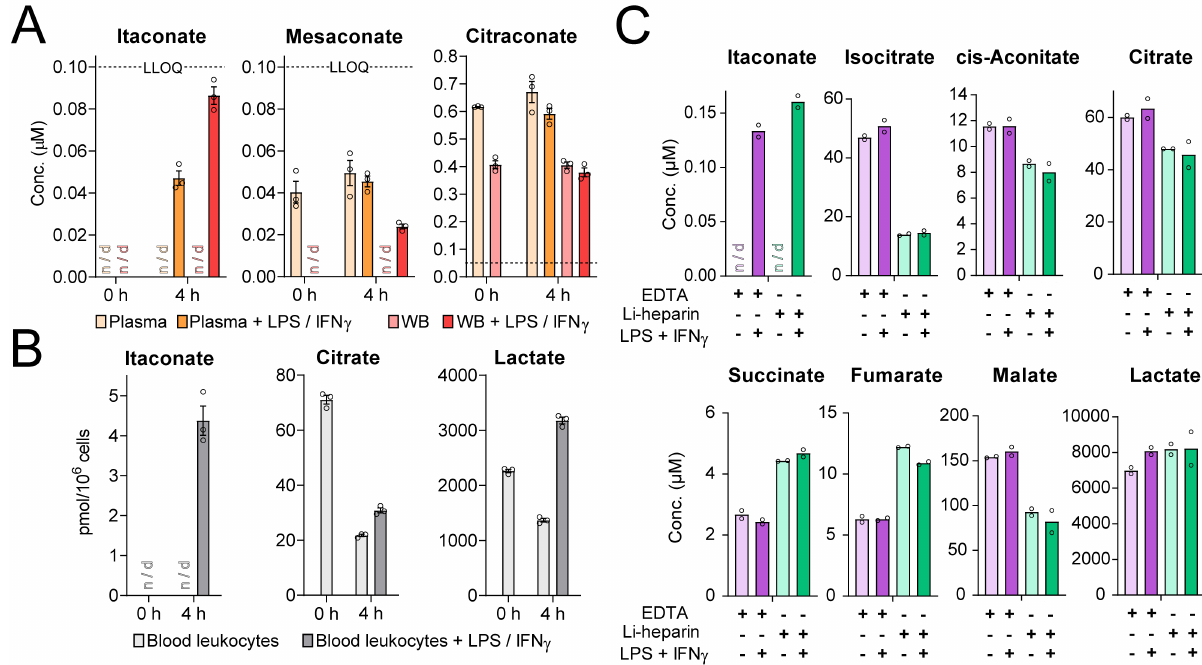
Figure 2. Itaconate levels in LPS/IFN γ stimulated whole blood. ( A )—Itaconate and mesaconate were detectable in whole blood (WB) and plasma after 4 h of stimulation, but could not be quantified reliably, since concentrations were <LLOQ. Citraconate levels were significantly higher, but not affected by LPS/IFN γ stimulation. Plasma was obtained from Li-heparin anticoagulated blood collection tubes. Dashed line marks LLOQ. Samples from donor A; n = 3 aliquots from the same blood draw; mean SEM; n/d: not detected. Concentrations of TCA intermediates from this experiment are shown in Figure S1. ( B )—Itaconate levels were quantifiable in blood leukocytes present in buffy coats from donor A upon LPS/IFN γ -stimulation; n = 3; mean SEM; n/d: not detected Citrate and lactate are shown to reveal the shift towards aerobic glycolysis. ( C )—Comparison of TCA metabolite levels in EDTA and Li-heparin blood stimulated with LPS/IFN γ for 4 h. Itaconate was quantifiable in both preparations of stimulated blood, but mesaconate and citraconate levels were not detectable. TCA metabolite levels varied greatly when comparing EDTA and Li-heparin blood while citraconate and mesaconate levels were <LLOQ. Samples from donor B, n = 2 replicates from the same blood draw; mean; n/d: not detected.